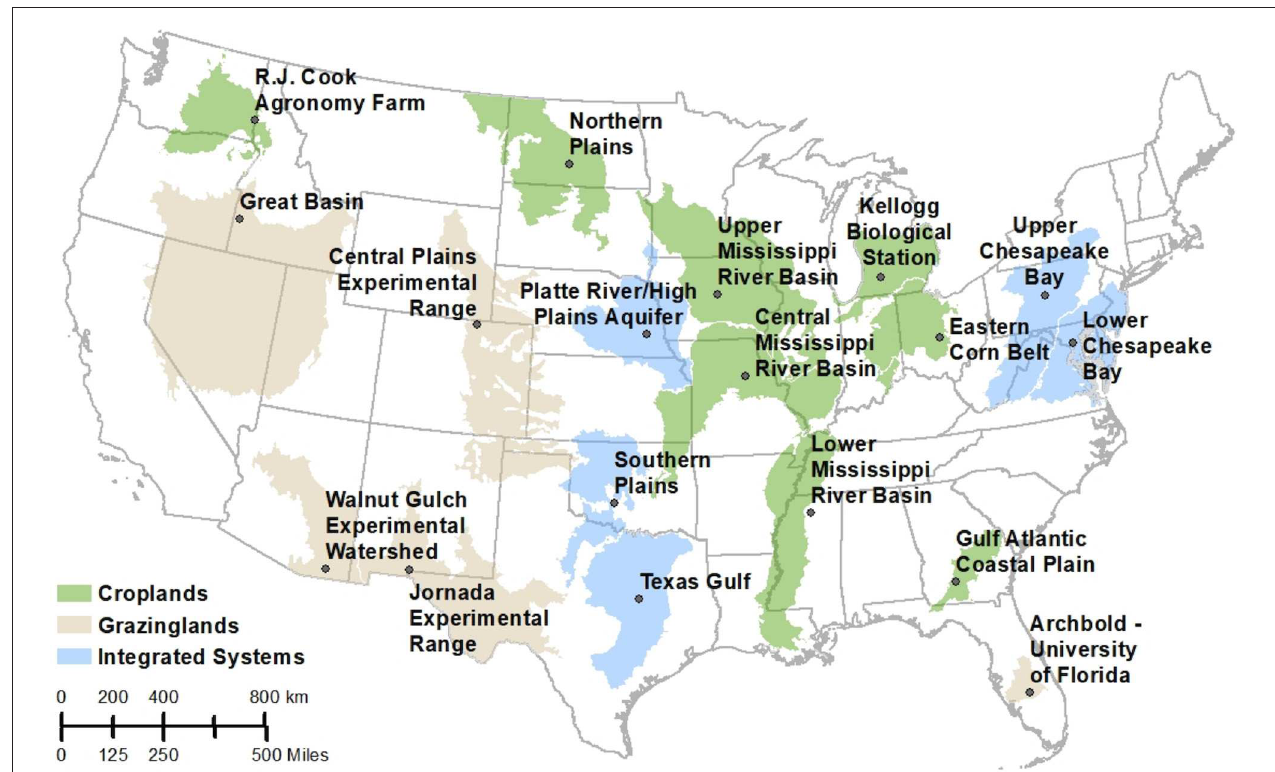
FIGURE 1 | Map of continental United States with USDA-ARS sites participating in the Long-Term Agroecosystems (LTAR) Network. Source: